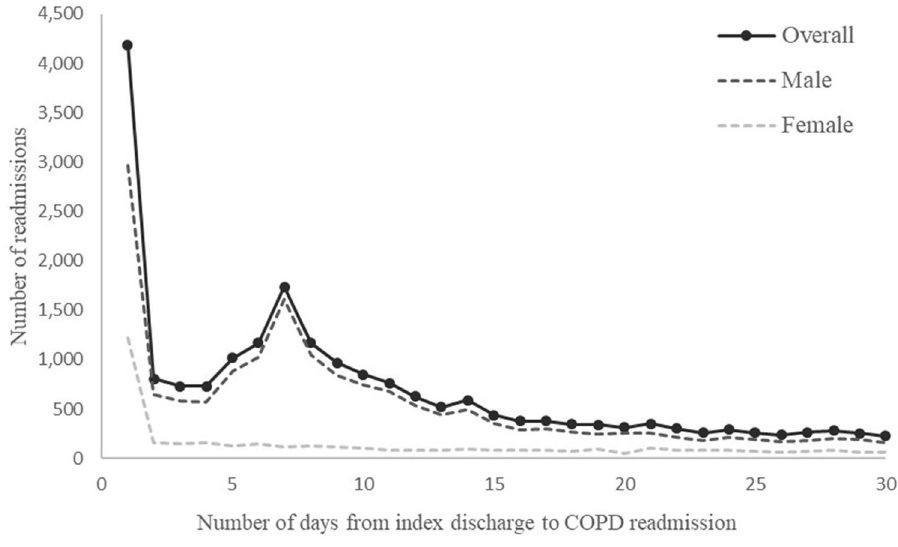
Figure 1. Distribution of time from index discharge to COPD readmission within 30 days.